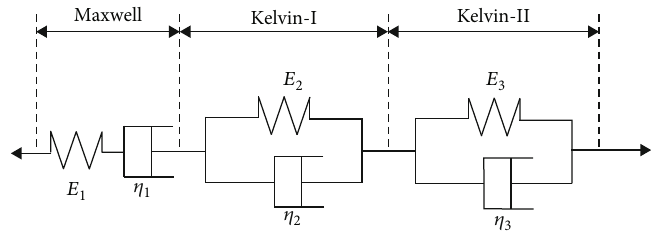
Figure 2: Generalized Burgers creep model.